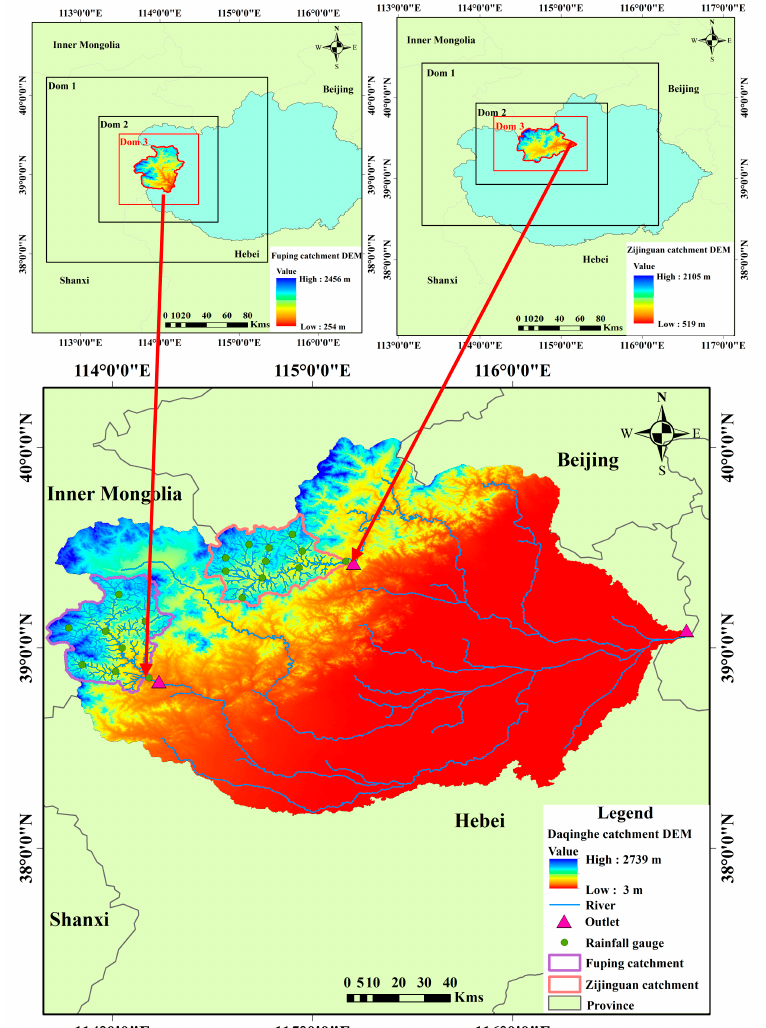
Figure 1. Locations and digital elevation models (DEMs) of the two study catchments in northern China with the gauges and the settings of the Weather Research and Forecasting model (WRF) nested